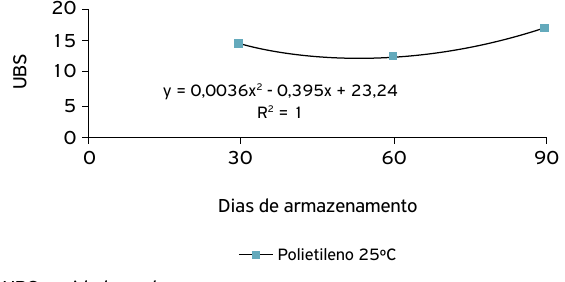
Figura 8. Conteúdo de água (umidade em base seca) de uma mistura granulada com conídios de B. bassiana acondicionada em embalagens de polietileno durante 180